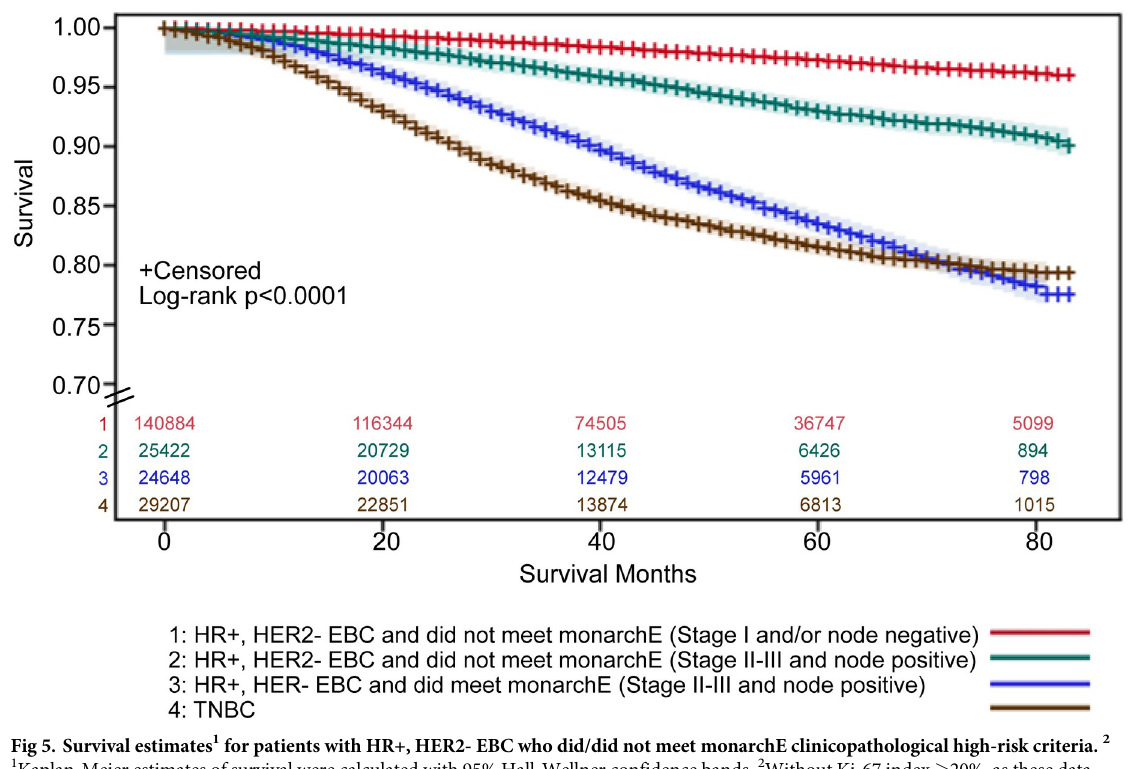
Fig 5. Survival estimates 1 for patients with HR+, HER2- EBC who did/did not meet monarchE clinicopathological high-risk criteria. 2 1 Kaplan-Meier estimates of survival were calculated with 95% Hall-Wellner confidence bands. 2 Without Ki-67 index � 20%, as these data were not available in the SEER database. ⸗ Indicates y-axis was truncated to 0.70–1.00. Abbreviations: EBC, early breast cancer; HER, human epidermal growth factor receptor; HR, hormone receptor; SEER, Surveillance, Epidemiology, and End Results; TNBC, triple negative breast